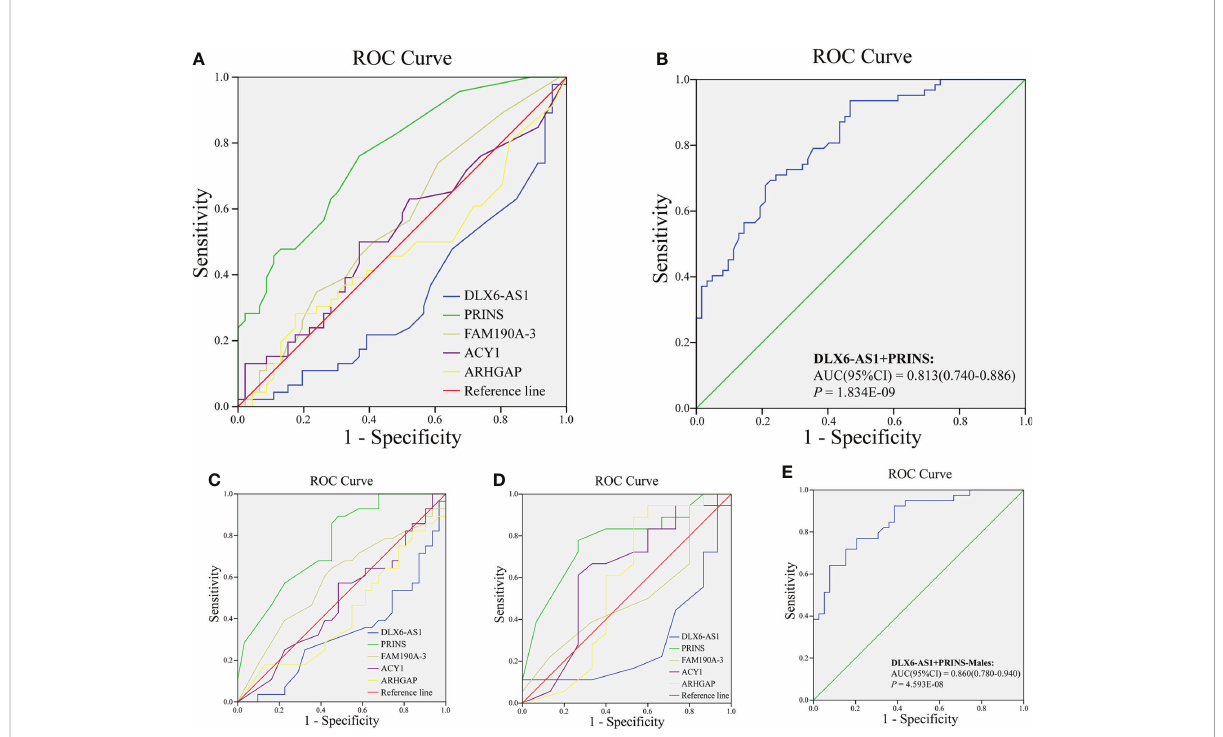
FIGURE 1 Analysis of diagnostic value of exosomal lncRNA in DR. The ROC curve of (A) lncRNA DLX6-AS1 , PRINS , FAM190A-3 , ACY1 , and ARHGAP ; (B) combining DLX6-AS1 with PRINS to diagnose DR in all population. The ROC curve of lncRNA DLX6-AS1 , PRINS , FAM190A-3 , ACY1 , and ARHGAP to diagnose DR in (C) males and (D) females. (E) The ROC curve of combining DLX6-AS1 with PRINS to diagnose DR in